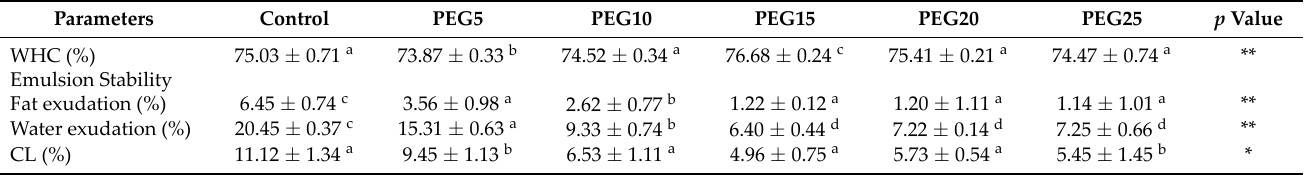
Table 5. Physico‑chemical characteristics of semi‑smoked sausage produced with different amounts of